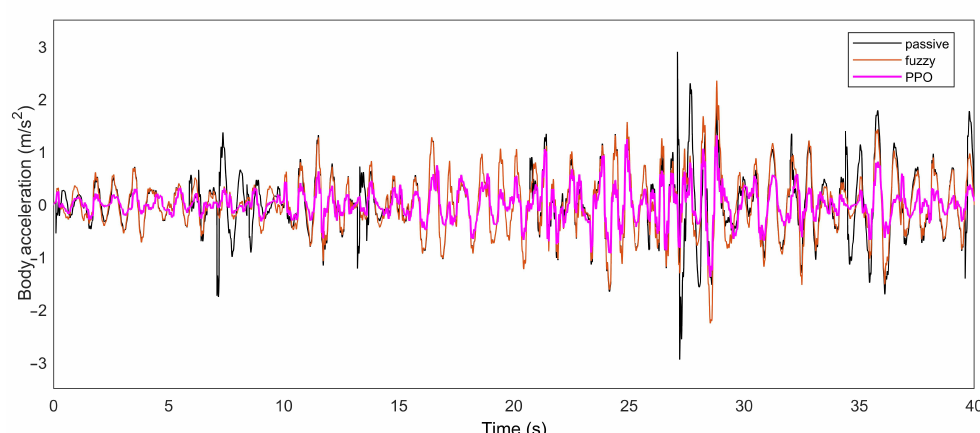
Figure 9. Continuously changing road.